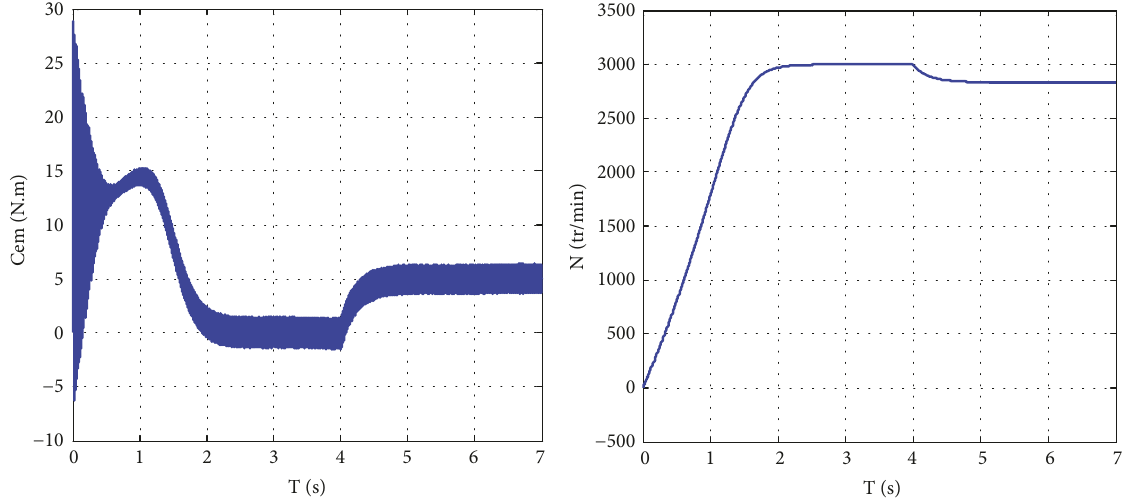
Figure 7: Electromagnetic torque and rotational speed for m = 2.